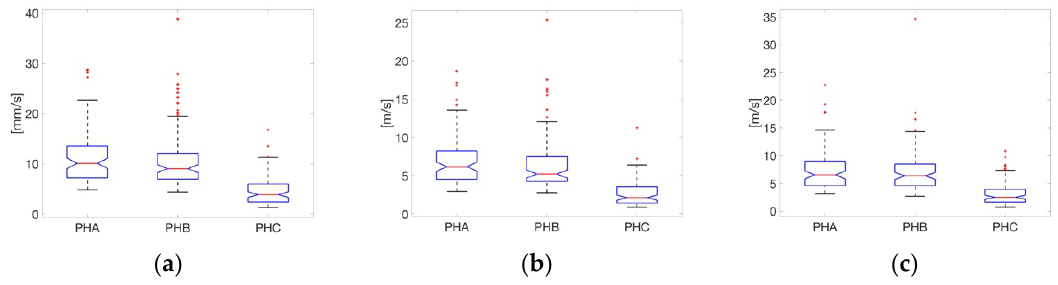
( c ) Figure 9. Range distributions for each of the three phases PHA, PHB and PHC: ( a ) RANGE distributions, ( b ) RANGEX distributions and ( c ) RANGEY distributions. Considering the velocity parameters distributions (Figure 10), a significant decrease in the